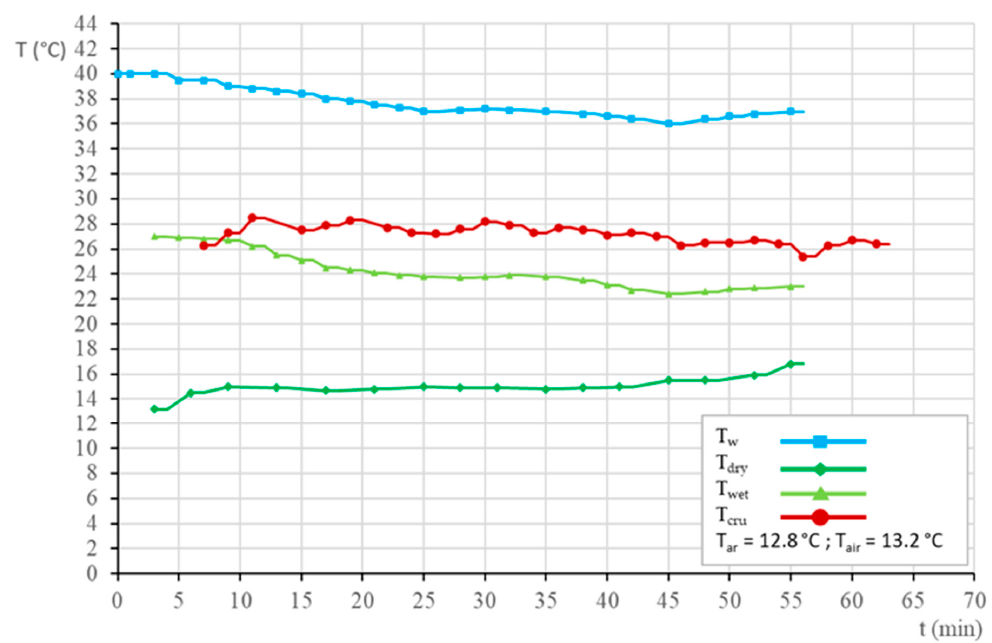
Figure 3. Evolution of the temperature during the processing of a batch of olives (‘Arbequina’ cv., 2134 kg). Each point represents a registration on one of the 4 different sites: the fruit temperature at the exit of the hopper (T dry ), the water temperature in the washing tub (T w ), the temperature exiting the washing tub (T wet ), and the temperature of the crushed olives (paste) before entering the malaxer (T cru ). On arrival, the fruit temperature was 12.8 ± 0.3 °C.